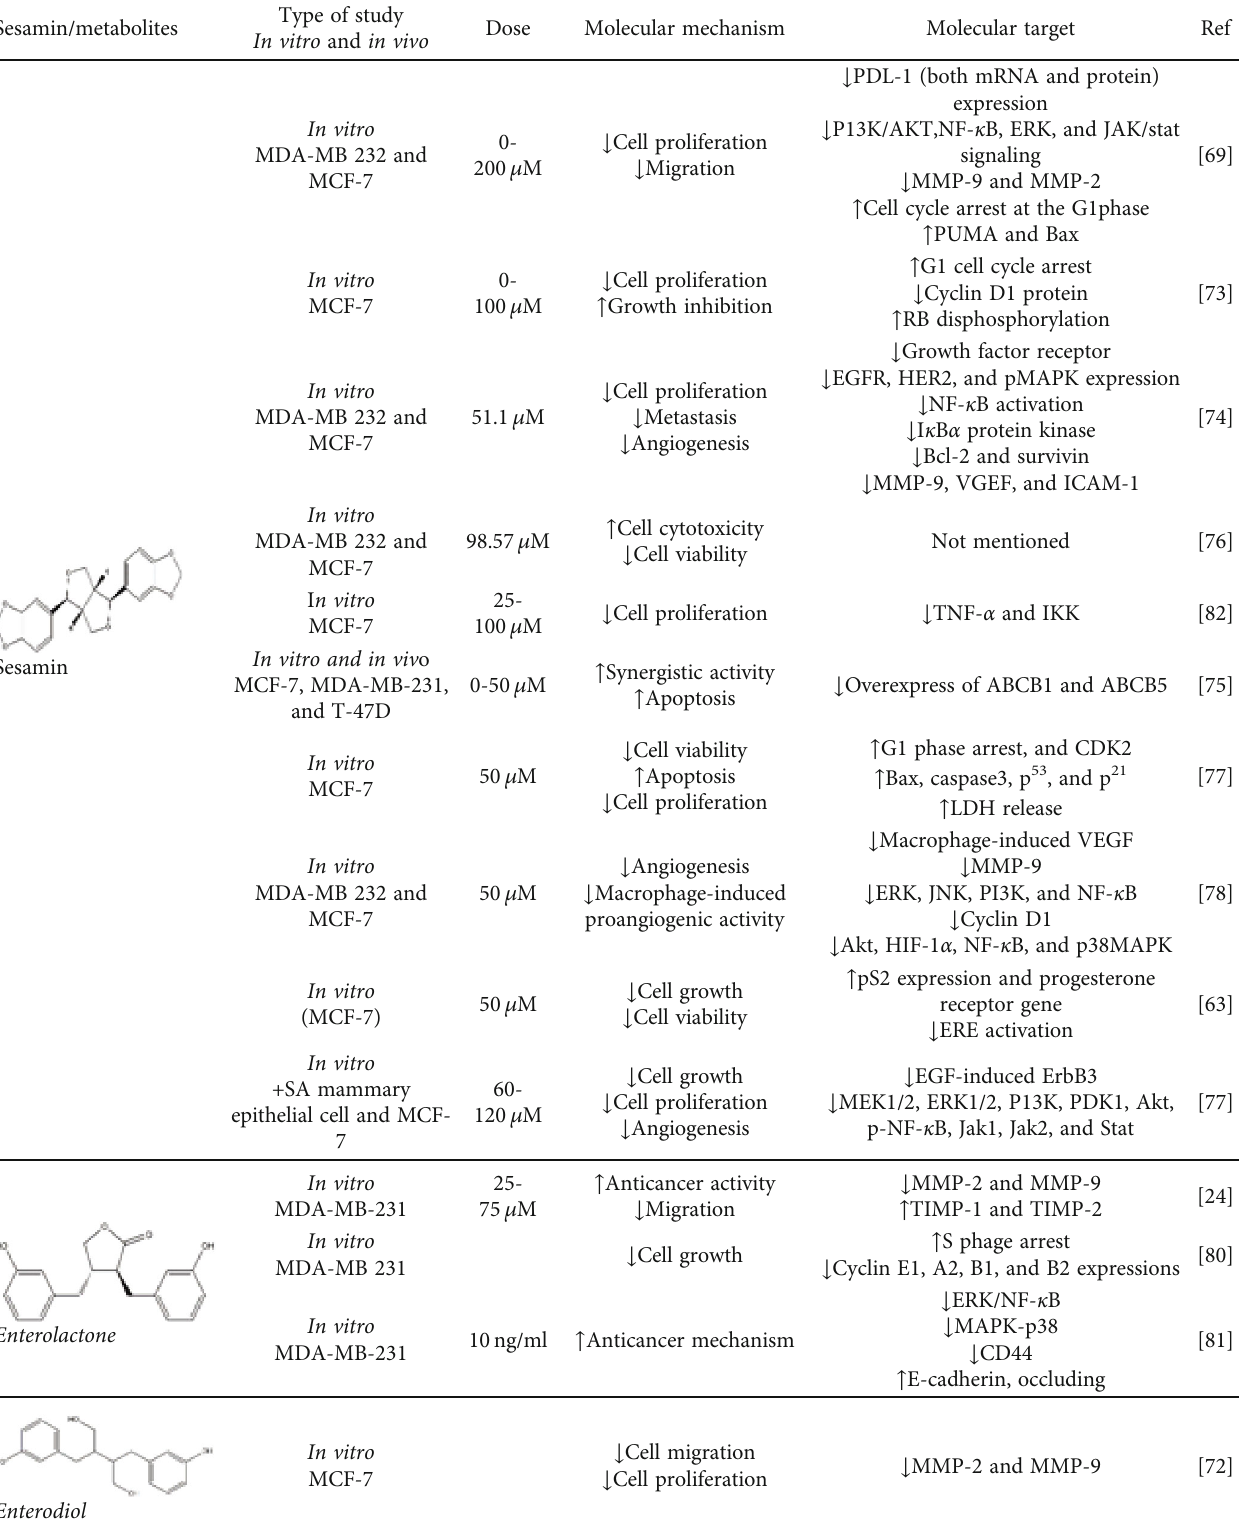
Table 2: Summary of the mechanisms of action of sesamin in in vitro breast cancer